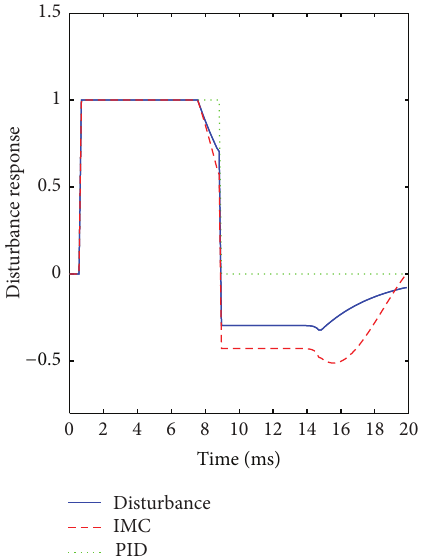
Figure8:EffectsoftheIMCandthePIDcontrollerwithdisturbance